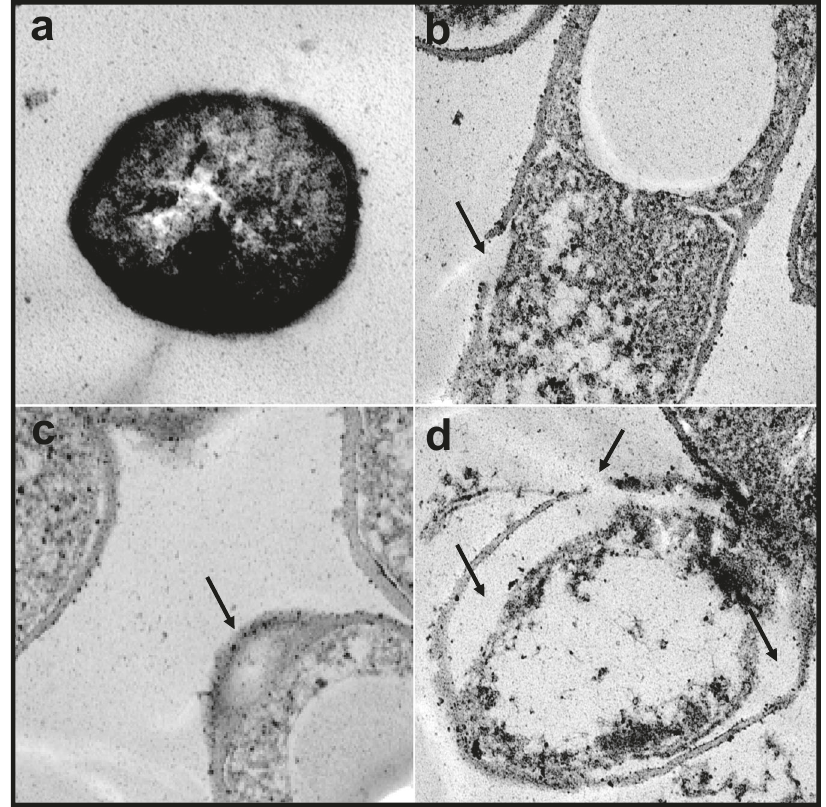
Fig. 6 Transmission electron micrographs (TEM) of B. cereus treated with HSEP3. TEM micrographs of B. cereus : a represents control (without peptide); b , c , and d represent different micrographs for HSEP3-treated cells (different fi elds from the same sample).